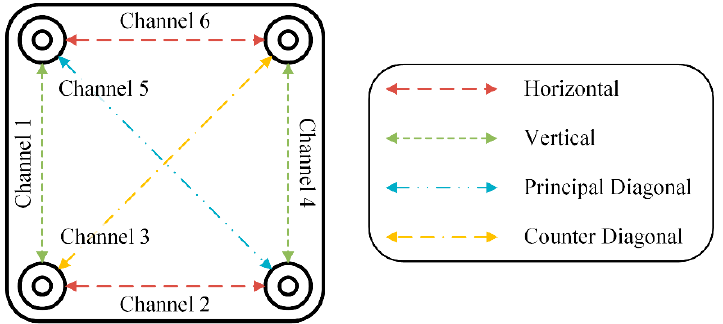
Figure 1. Simplified diagram of the wearable four-electrode electrocardiogram-sensor (WFEES) and its channels’ orientation.